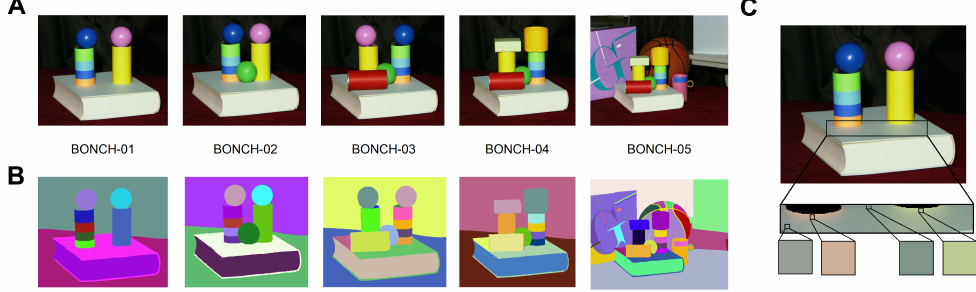
Figure 6. The ITTP-Close experimental dataset: ( A ) RGB images present in the dataset; ( B ) the cor- responding groundtruths; ( C ) a closer look at the different colors in one area, as defined by the ground